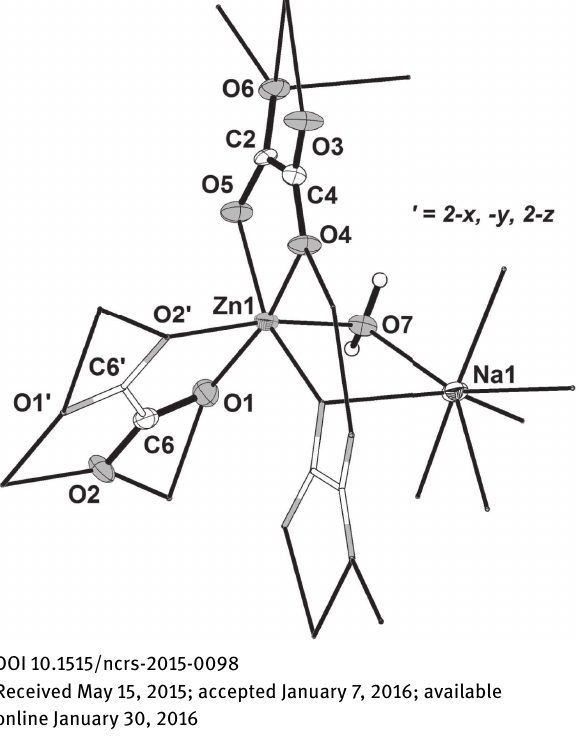
Table 1: Data collection and handling.